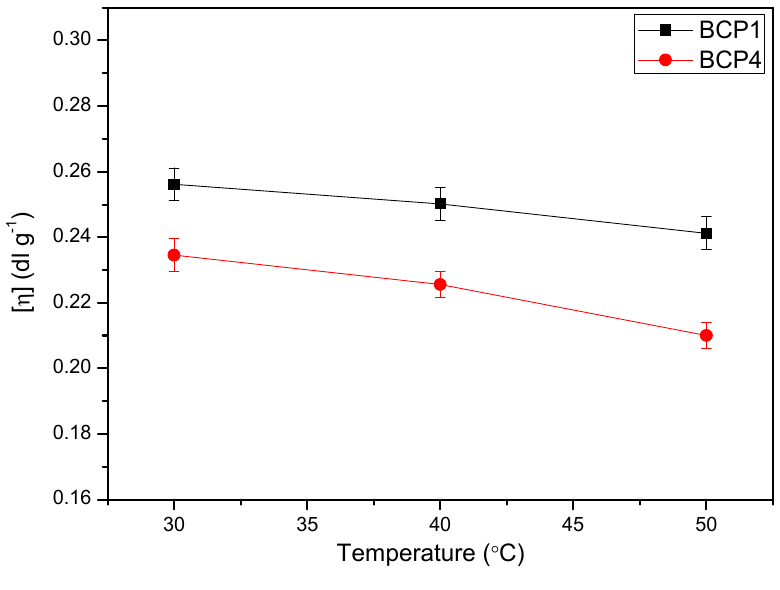
Figure 7. Effect of temperature on the intrinsic viscosity of copolymers BCP-1 and BCP-4 in